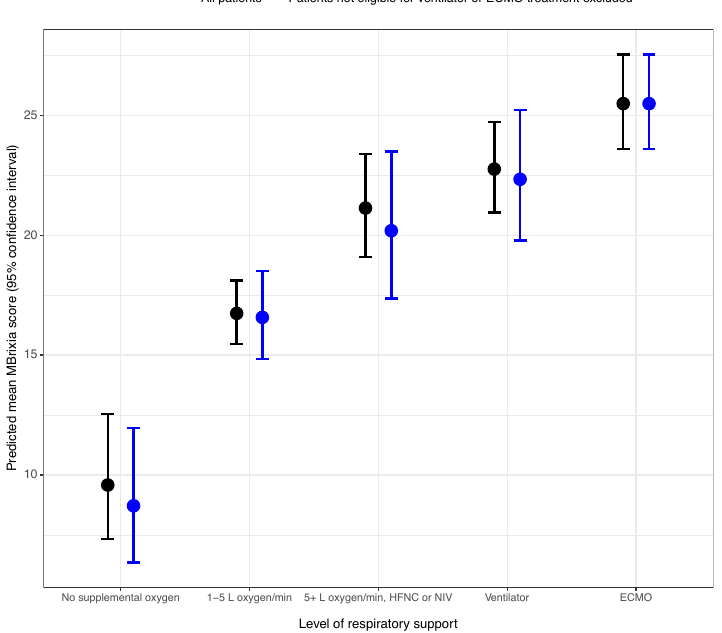
Figure 3. Predicted mean MBrixia score (95% confidence interval) by level of respiratory support.